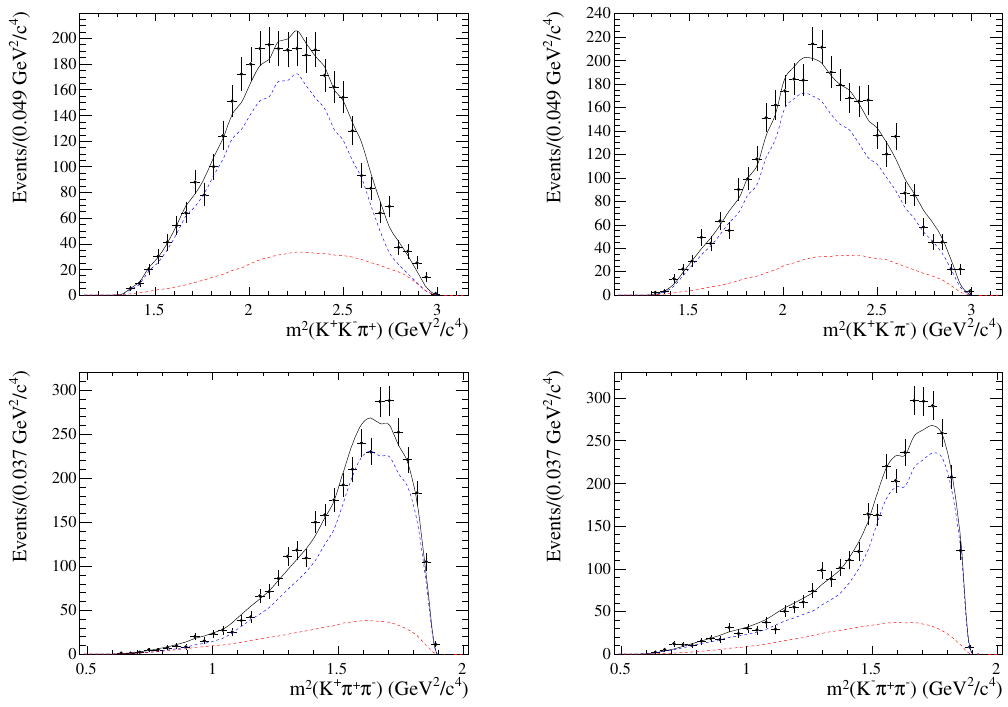
Figure 12 . Invariant 3-body mass distributions of D 0 ! K + K (cid:0) (cid:25) + (cid:25) (cid:0) signal events shown as points with error bars. The overall (cid:12)t projection is shown in black, the signal in blue and the background in